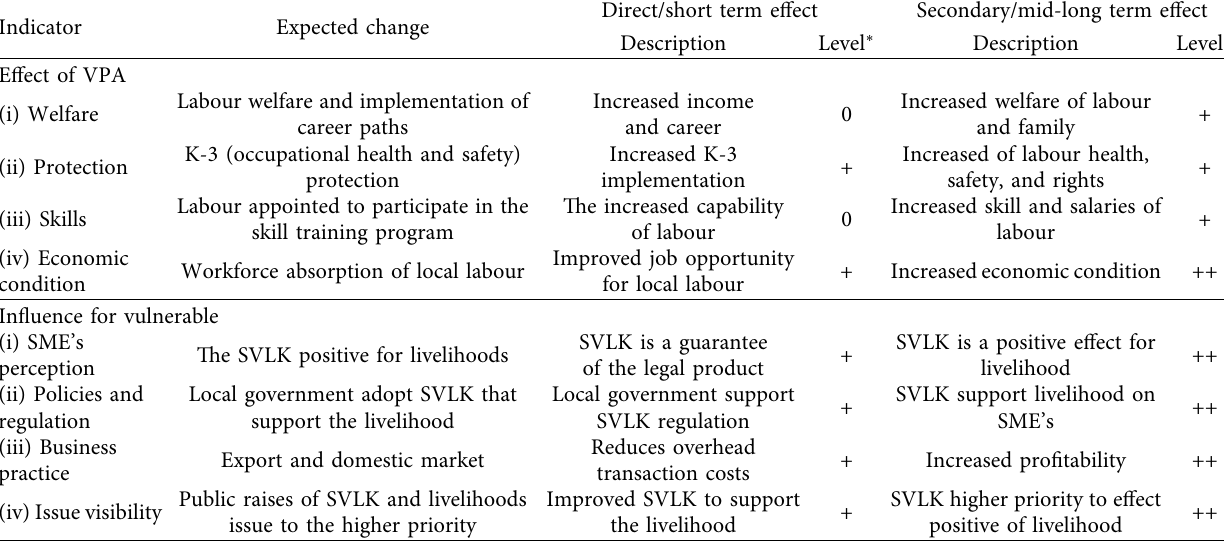
Table 2: The ToC analysis of the implementation effect of the SVLK on SME’s livelihood.